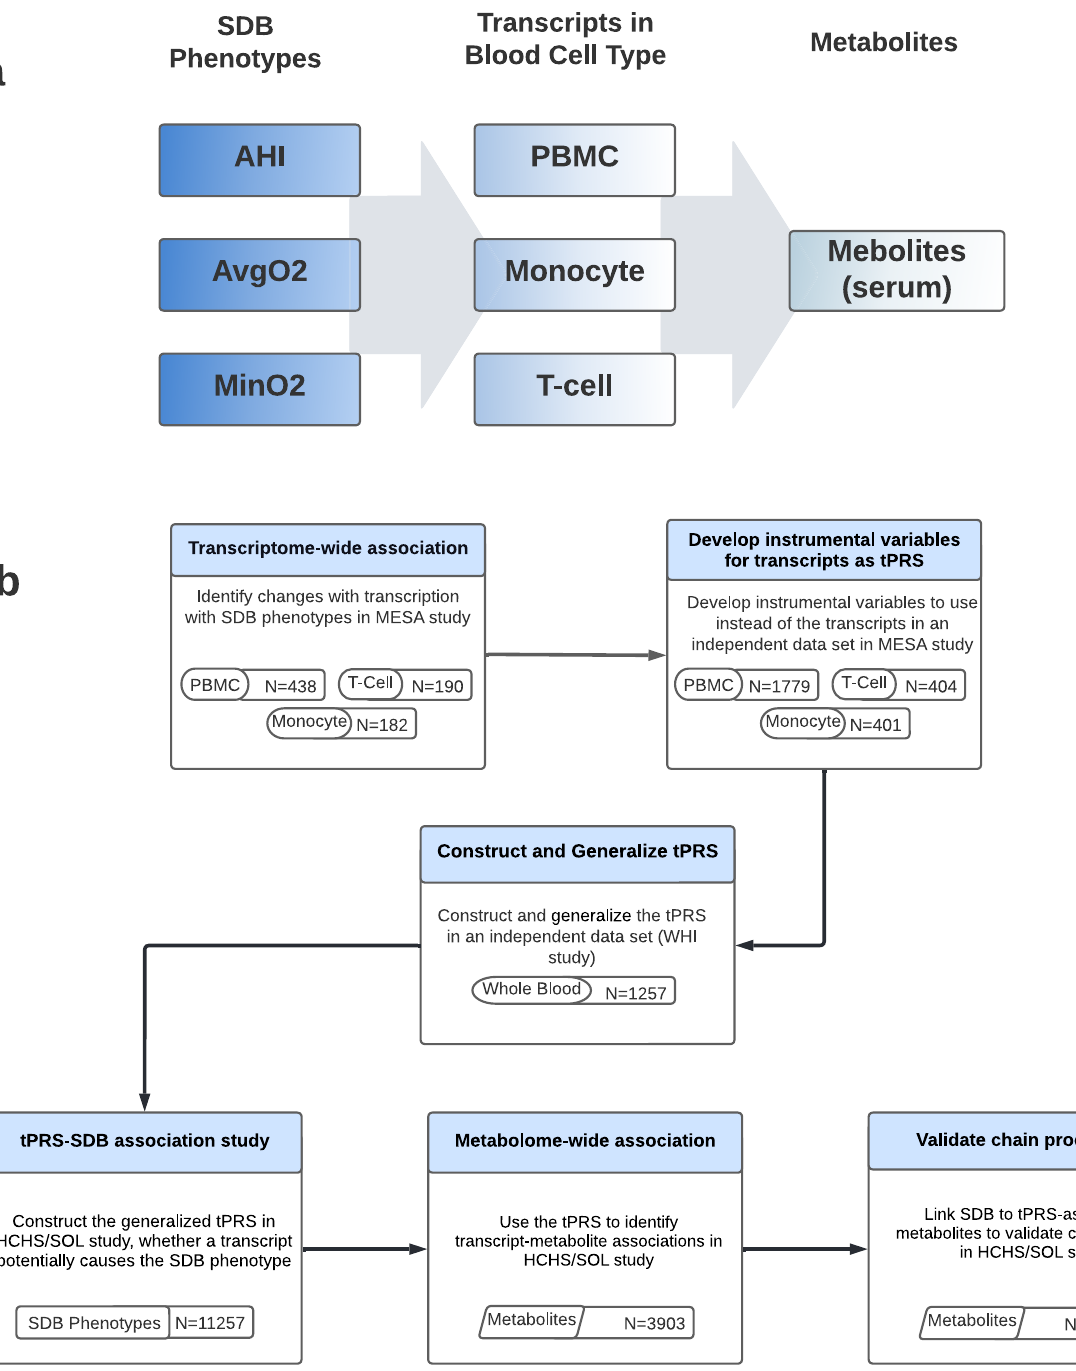
Fig. 4 Overall study design of the reported analysis. Flow charts illustrating the methodology and purpose of the analysis. The chart portrays the three SDB phenotypes evaluated in the analysis, the three blood tissues with transcript expression measurement, and demonstrates each step of the analysis with associated goals, cohorts, and reasons why step was performed. a Conceptual linking between SDB measures, transcript expression, and metabolites. b Analytic steps supporting the study of the conceptual links. PBMC tPRS analysis sample sizes in MESA correspond to data from two visits (some individuals were used twice, appropriately accounted for by mixed